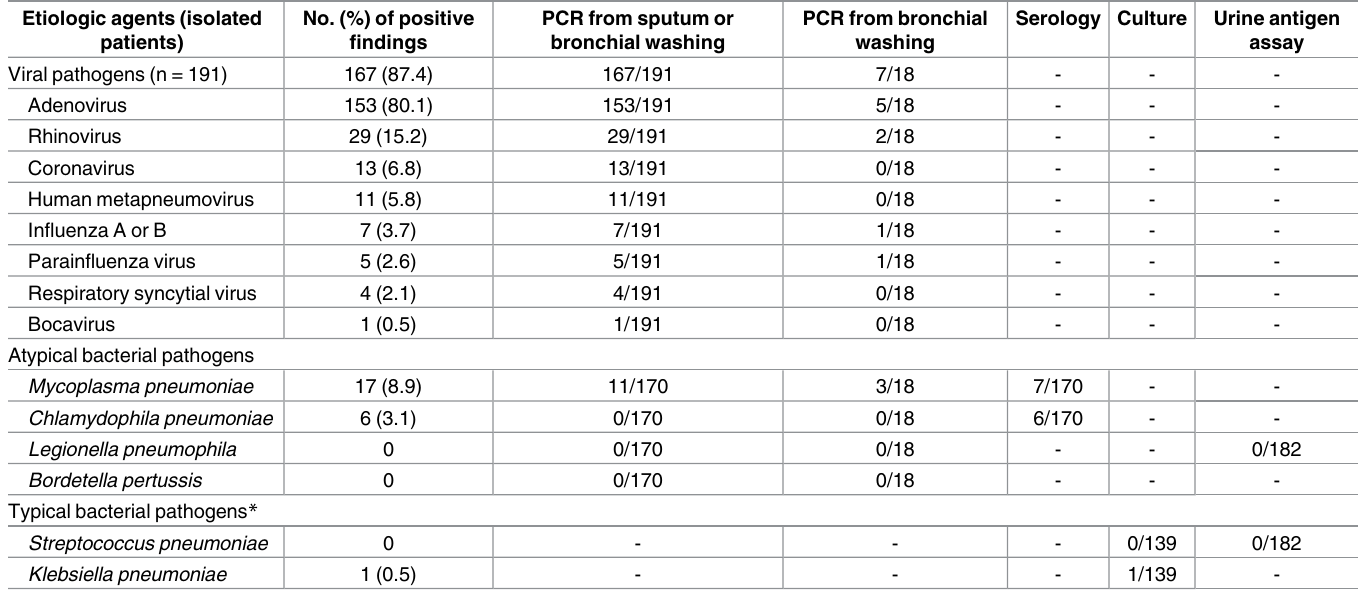
Table 2. Distribution of viral and bacterial pathogens in cases of community-acquired pneumonia in the military.